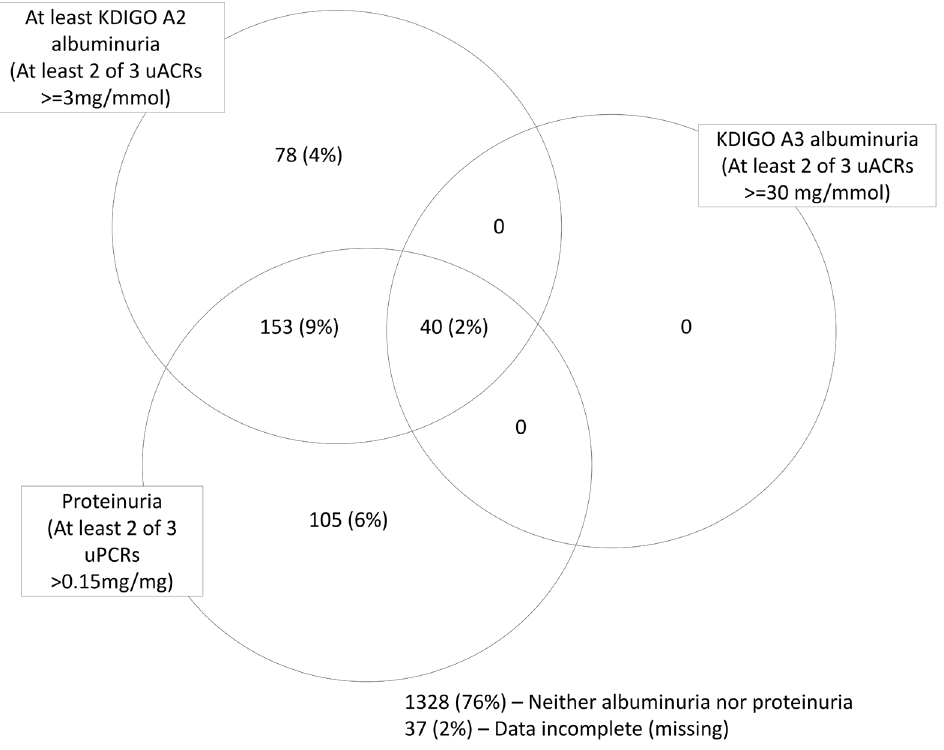
Figure 1. The distribution of albuminuria (based on 2 of 3 uACRs) and non-albumin proteinuria (based on 2 of 3 uPCRs) in people with chronic kidney disease stage 3 in the Renal Risk in Derby study.